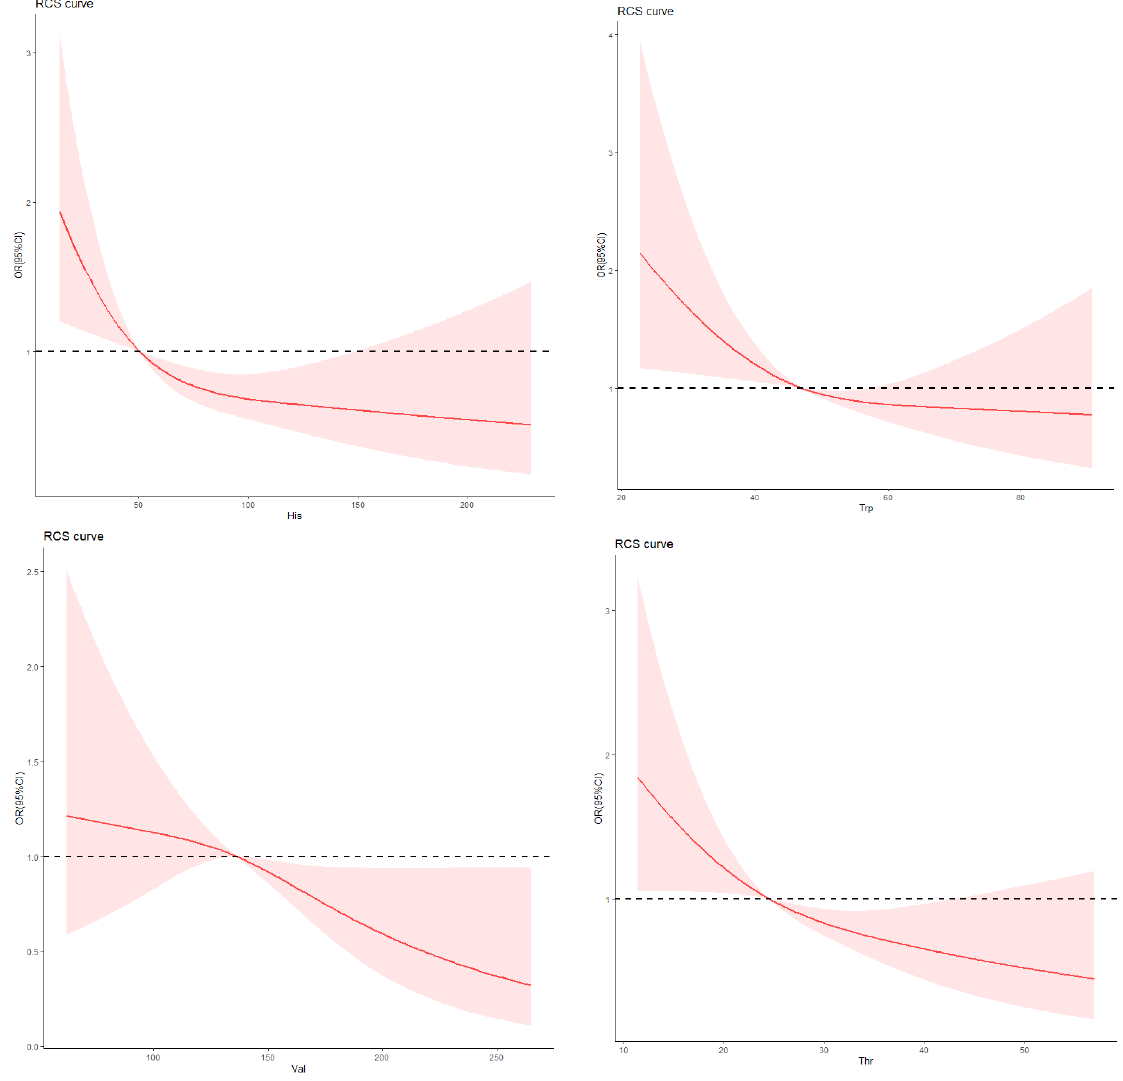
Figure 2. The RCS curve of His, Trp, Val and Thr. The red curve was derived from multivariate analysis that adjusted for age, gender, body mass index, systolic blood pressure, diastolic blood pressure, low-density lipoprotein cholesterol, high-density lipoprotein cholesterol, triglyceride, glycosylated hemoglobin, uric acid, serum creatinine, and duration of diabetic nephropathy. His, histidine; Trp, tryptophan, Val, valine; Thr, threonine.